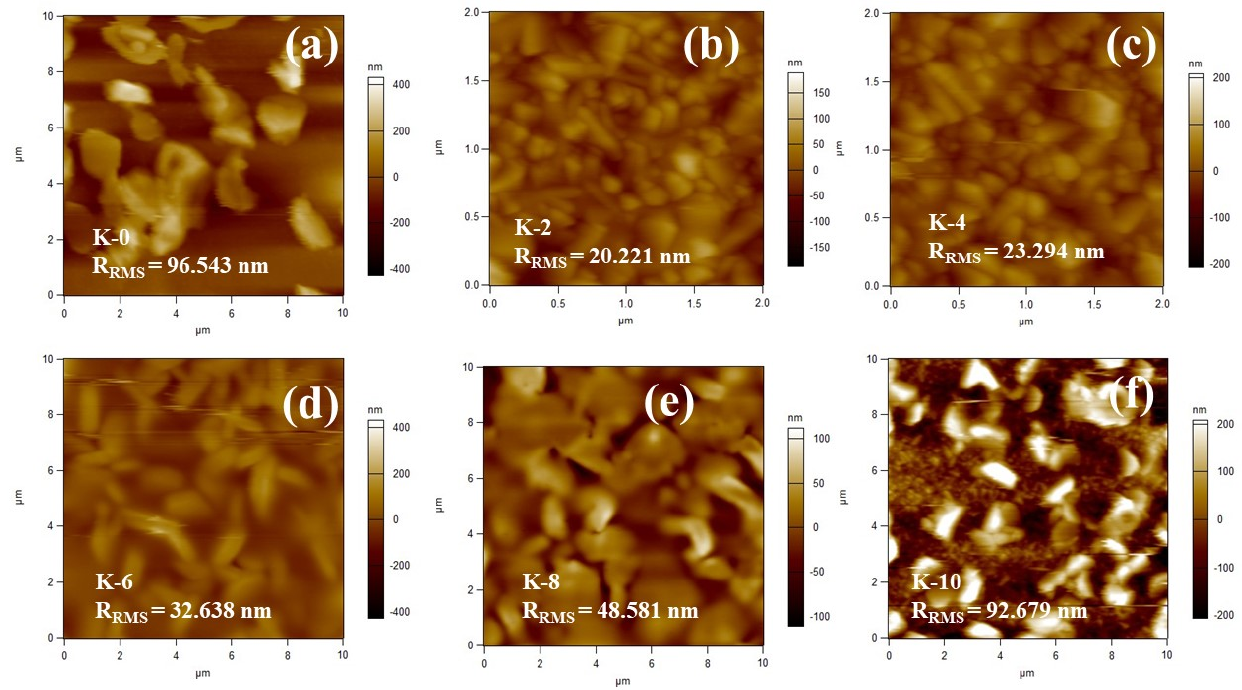
Figure 5. ( a ) AFM 2D topography images for deposited Cs 3 Bi 2 I 9 (K-0) perovskite film. ( b – f ) AFM 2D topography images for Cs 3 Bi 2 I 9 perovskite films with the incorporation of K + (K-2 to K-10).